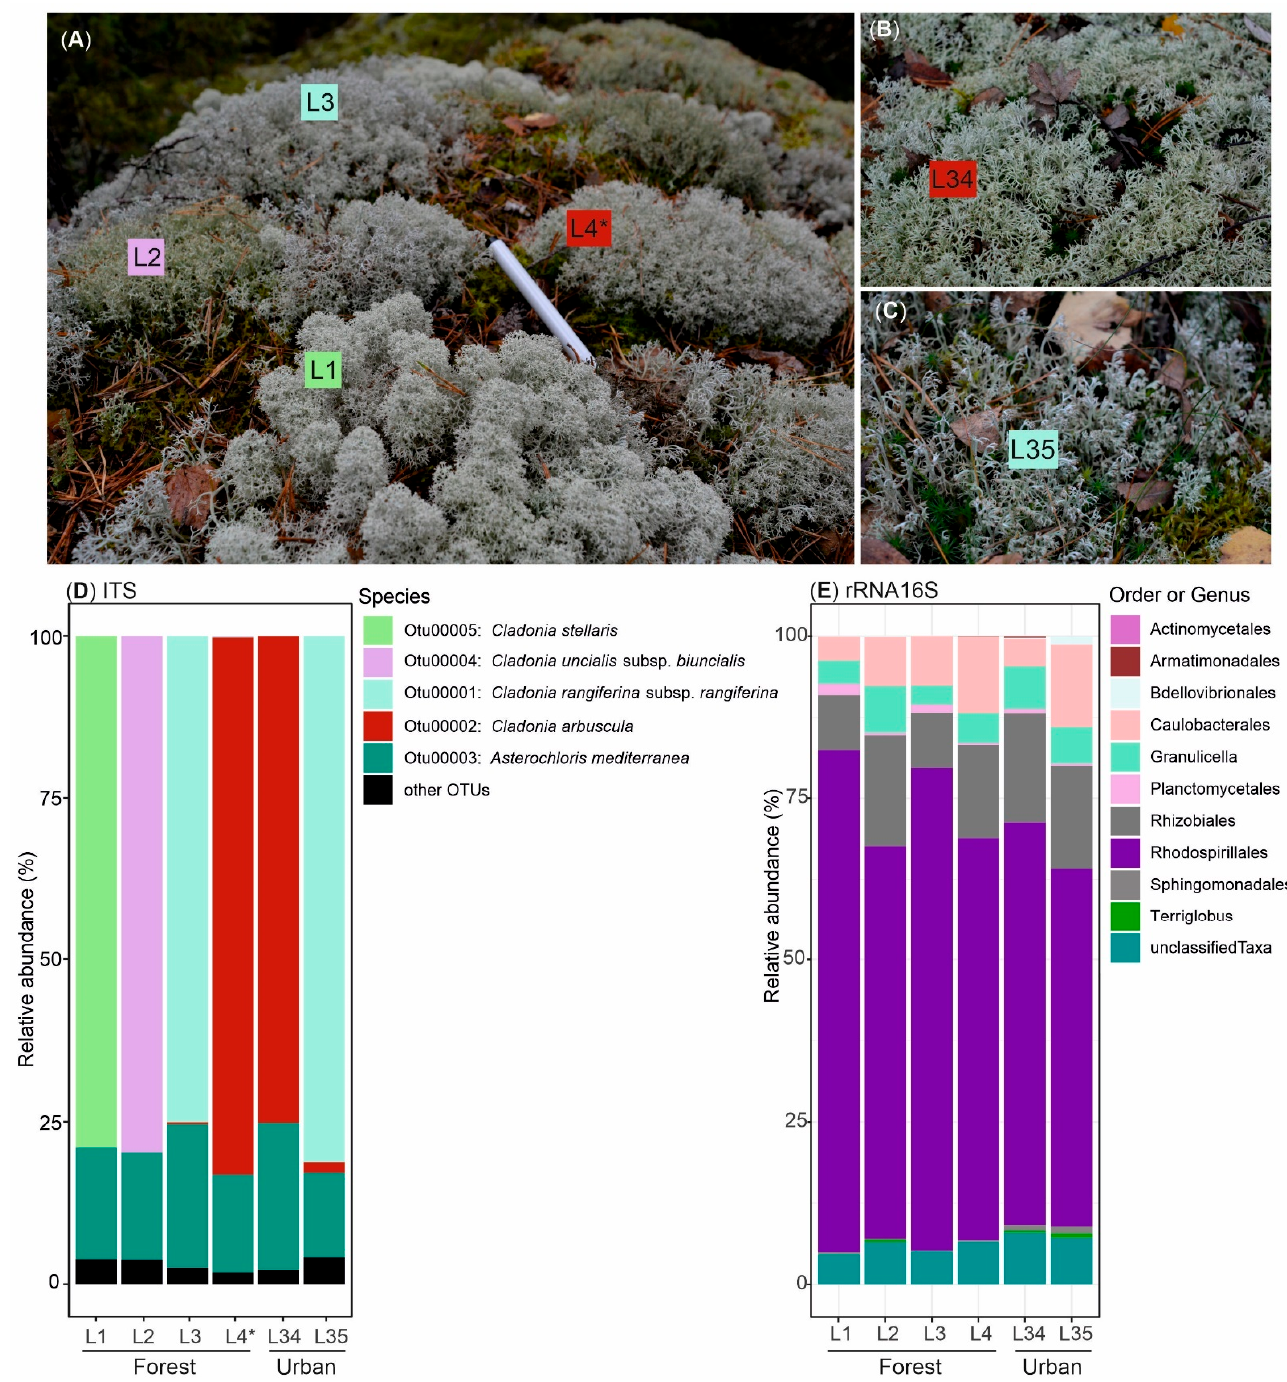
Figure 1. Lichens with the main fungal partner species belonging to the genus Cladonia included in this study. Photo of four Cladonia specimens collected in the boreal forest site ( A ) and two from the urban area ( B , C ). Communities of classified eukaryotes ( D ) and bacteria ( E ) obtained through analysis of amplicon DNA OTU sequences of the internal transcribed spacer 2 (ITS2) and 16S rRNA encoding gene V3-V4 (rRNA 16S) regions. * Sample L4 was later classified as Cladonia mitis